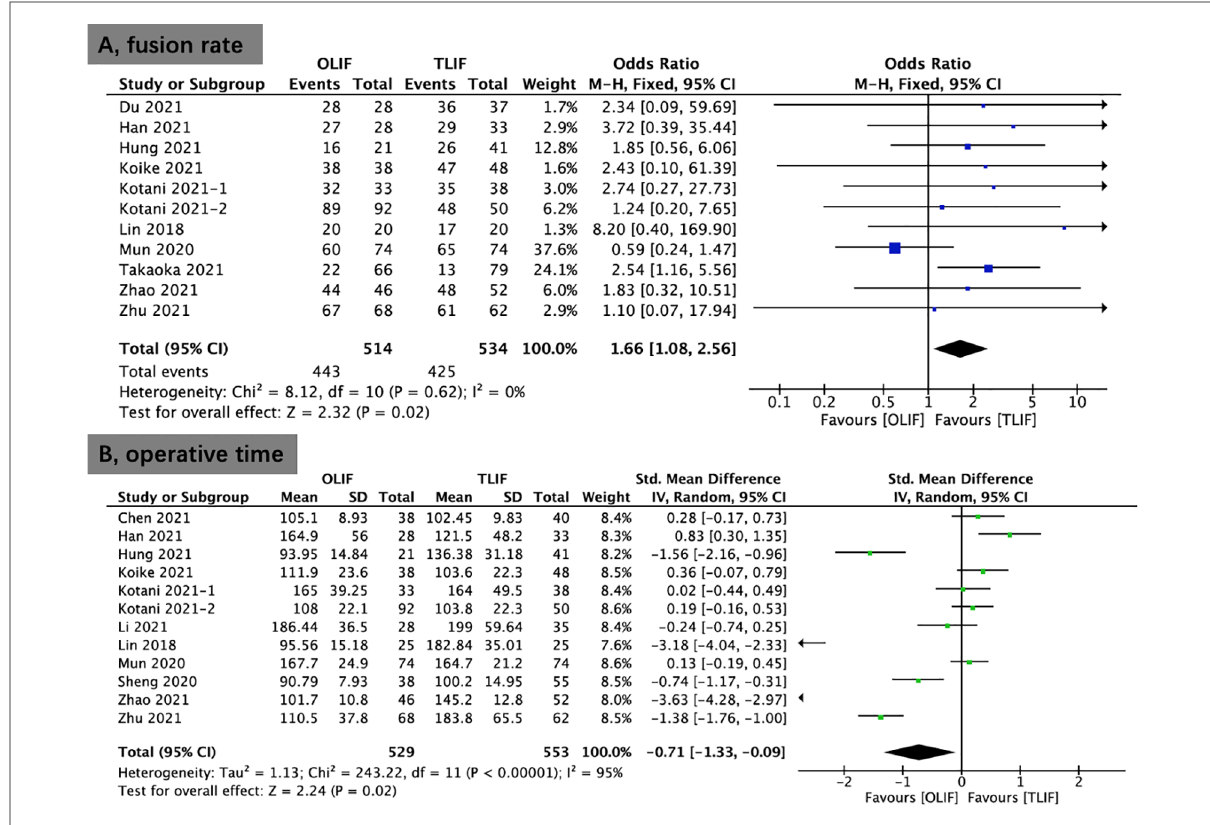
FIGURE 7 Forest plots comparing fusion rate ( A ) and operative time ( B ) between OLIF and TLIF. OLIF, oblique lumbar interbody fusion; TLIF, transforaminal lumbar interbody